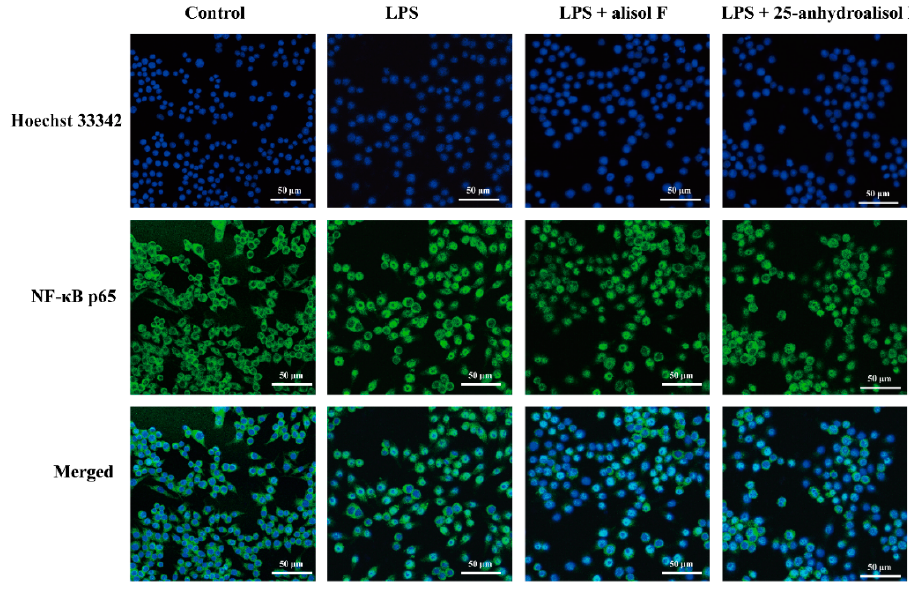
Figure 5. The effect of alisol F and 25-anhydroalisol F on the translocation of the NF- κ B p65 subunit into the nucleus of LPS-simulated RAW 264.7 cells. Cells were pretreated with the alisol F (33 μ M) and 25-anhydroalisol F (33 μ M) for 2 h, and then stimulated with or without LPS (1 μ g/mL) for 30 min. The translocation of NF- κ B p65 was determined by immunocytochemistry. Hoechst 33342 was used to stain the nucleus of cells (blue). The cytoplasm was marked by the anti-NF- κ B p65 antibody followed by fluorescein isothiocyanate (FITC)-conjugated anti-rabbit lgG (green). In light of the roles of alisol F and 25-anhydroalisol F in NF- κ B, the questions were easily raised whether the upstream signaling pathways were also regulated by the two compounds. MAPKs,